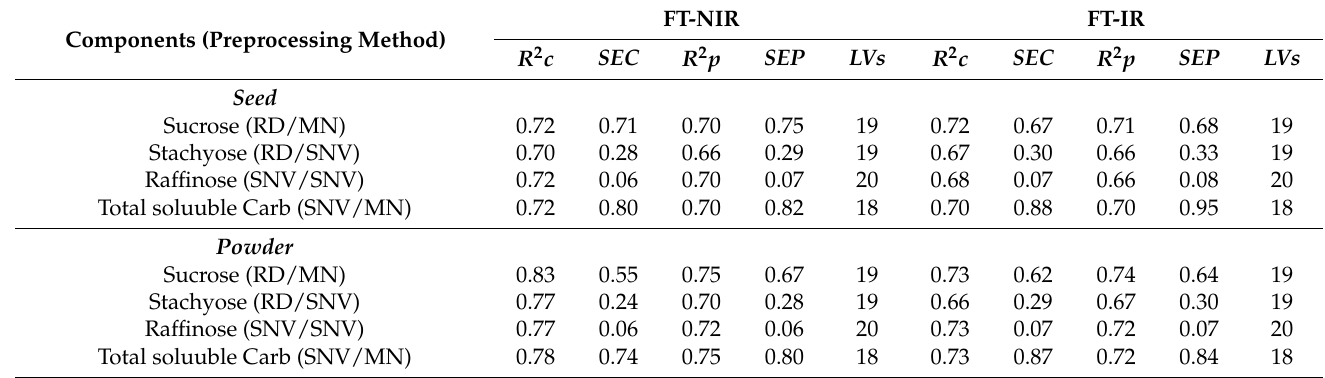
Table 3. The PLSR statistical model for predicting total oligosaccharides and short-chain carbohy- drates in soybean using FT-NIR and FT-IR